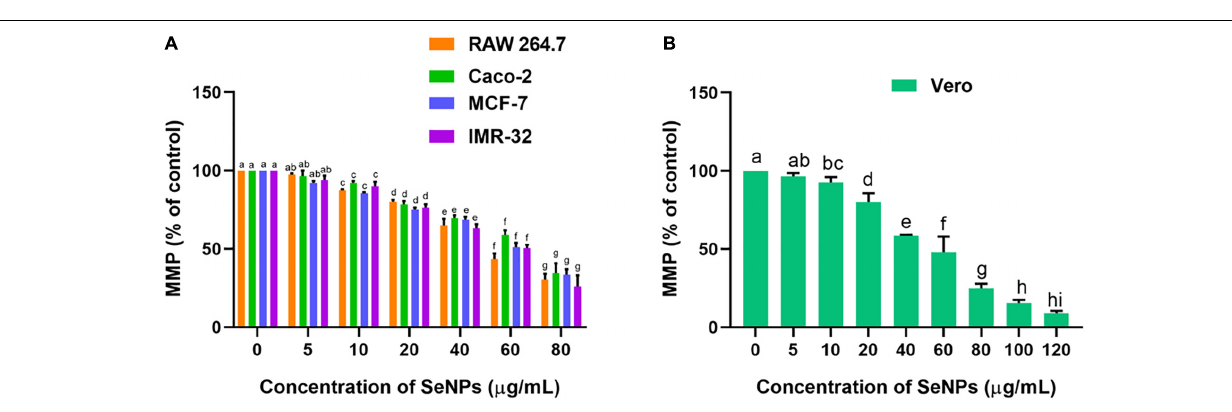
FIGURE 12 | Dose-dependent effect of SeNPs on MMP of (A) cancer cells and (B) normal cells. The experiments in the study were carried out three times, each time independently. The mean and SD of the triplicate research were calculated using the results from each experiment. The bar graphs with different letters within the particular analysis were significant ( p -value ≤ 0.05) by Tukey’s